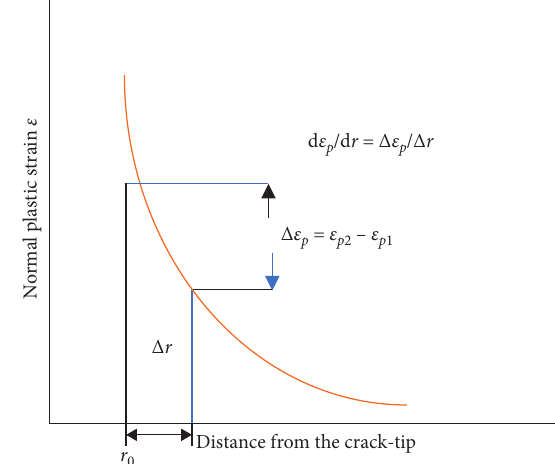
Figure 3: Process of calculating strain gradient with respect to crack